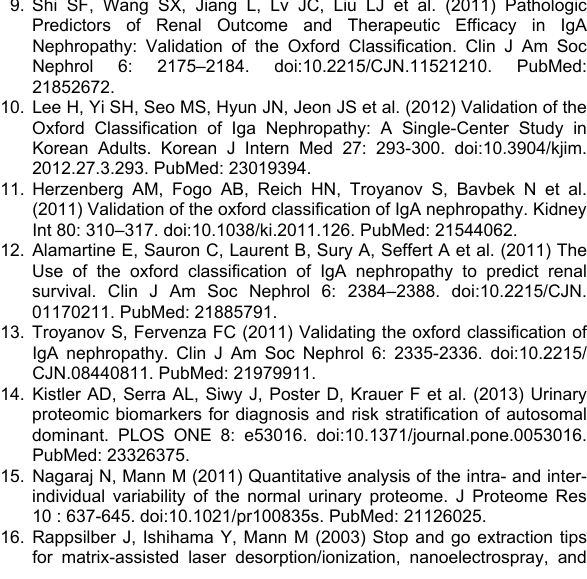
Table S4. The significant molecular functions with related proteins and p-values for under-represented markers.